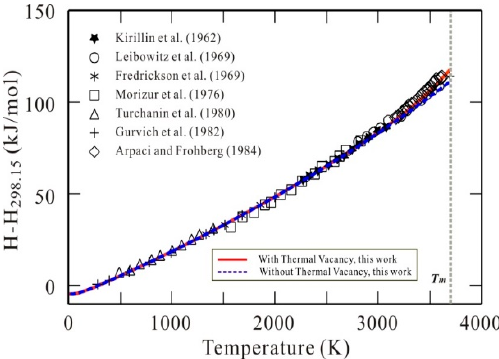
Figure 2. Heat contents ( H − H 298.15 ) of bcc W as a function of temperature. Symbols: Experimental data [14,34–39]. Solid line (red): Calculated results according to the presently established Gibbs energy for bcc W with thermal vacancy contribution. Dashed line (blue): Calculated results according to the presently established Gibbs energy for defect-free bcc W without thermal vacancy contribution.